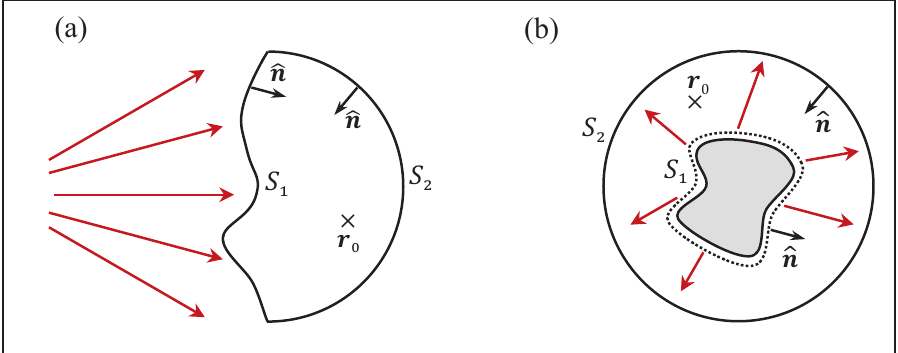
Fig.1 . Two surfaces (cid:1845) and (cid:1845) bound the scattering region, which is assumed to be free of sources and (cid:2869) (cid:2870) material bodies. All the radiation within the scattering region comes from the outside. In (a) the , while in (b) the radiation emanates from the sources of radiation are on the left-hand side of (cid:1845) (cid:2869) . The observation point (cid:2200) is an arbitrary point within the sources inside the closed surface (cid:1845) (cid:2869) (cid:3116) are assumed to be far away from (cid:2200) , so that the fields scattering region. All the points located on (cid:1845) (cid:2870) (cid:3116) do not contribute to the fields observed at (cid:2200) . At each and every point on (cid:1845) and (cid:1845) , the that reach (cid:1845) (cid:2870) (cid:2869) (cid:2870) (cid:3116) surface normals (cid:2196)(cid:3549) point into the scattering